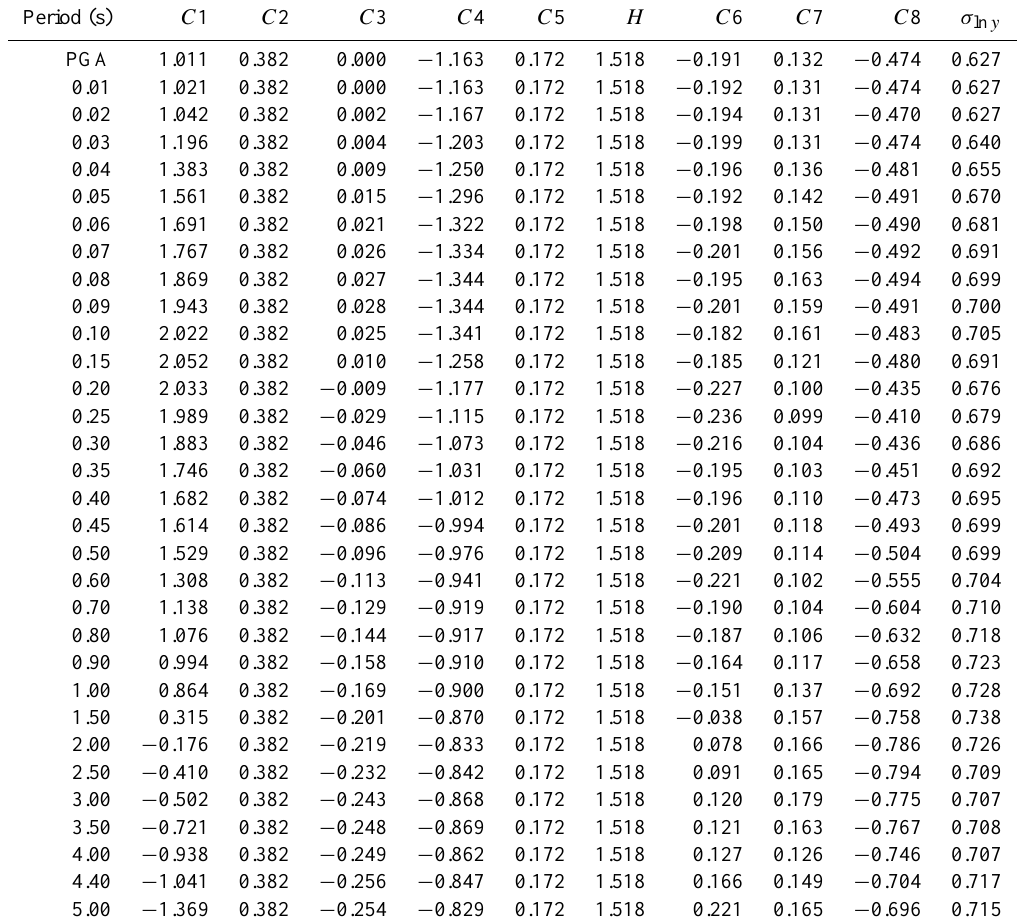
Table 2. Corresponding parameters and standard deviations ( σ ln y ) of the GMPEs for PGA and SA of various response periods for crustal events (Eq. 12) by Lin